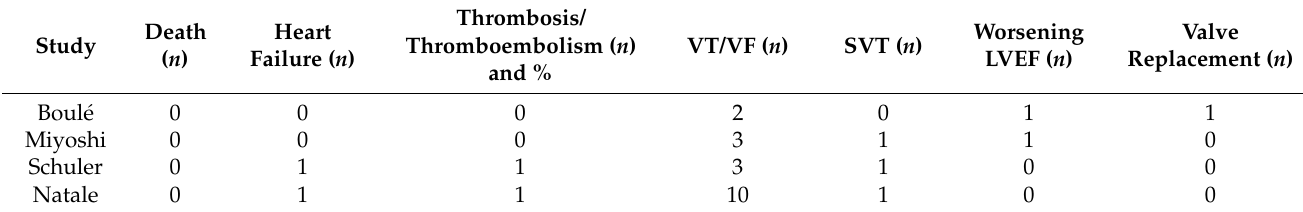
Table 5. Maternal complications of pregnancy with an ICD.